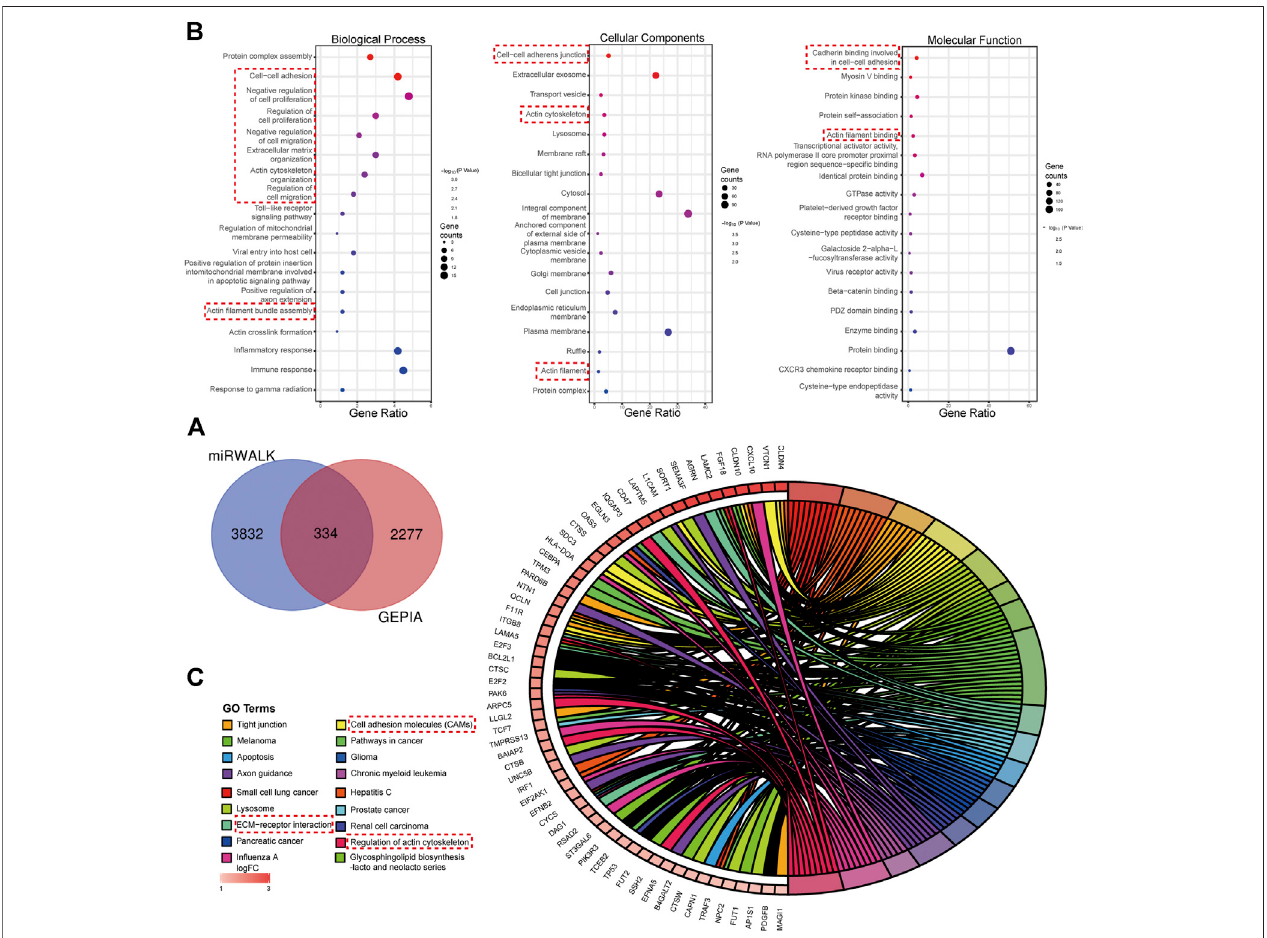
FIGURE 5 | Target genes interacted with miRNA-1827 and the functional enrichment analysis for these genes. (A) The Venn diagram for the overlapped targets predicted by different databases, with 4,166 genes from the miRWALK tool based on 12 servers and 2,611 highly expressed genes from the GEPIA tool based on the TCGA and GTEx databases (adjusted p < 0.05). (B) GO enrichment analysis processed by the DAVID online tool including the biological process (left panel), cellular component (middle panel), and molecular function (right panel), as shown in the bubble plots. The size of the circles referred to the gene counts, and the X-axis pointed to the gene ratio. (C) KEGG pathway enrichment. The chordal diagram displayed the pathway terms enriched in the KEGG database. The input genes derived from the highly expressed predicted targets.